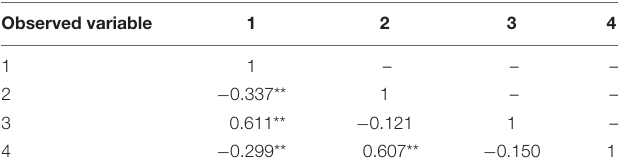
TABLE 2 | Correlations for CFA analysis of revised four-item survey on Singaporean graduate students. Observed variable